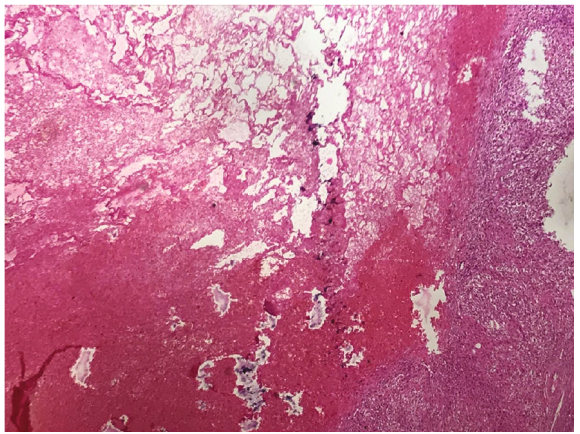
Figure 5: Microscopic pathologic examination showing epitheliogigantocellular granulomatous adenitis with a large lique fi ed necrosis in the center (HE, G × 50).